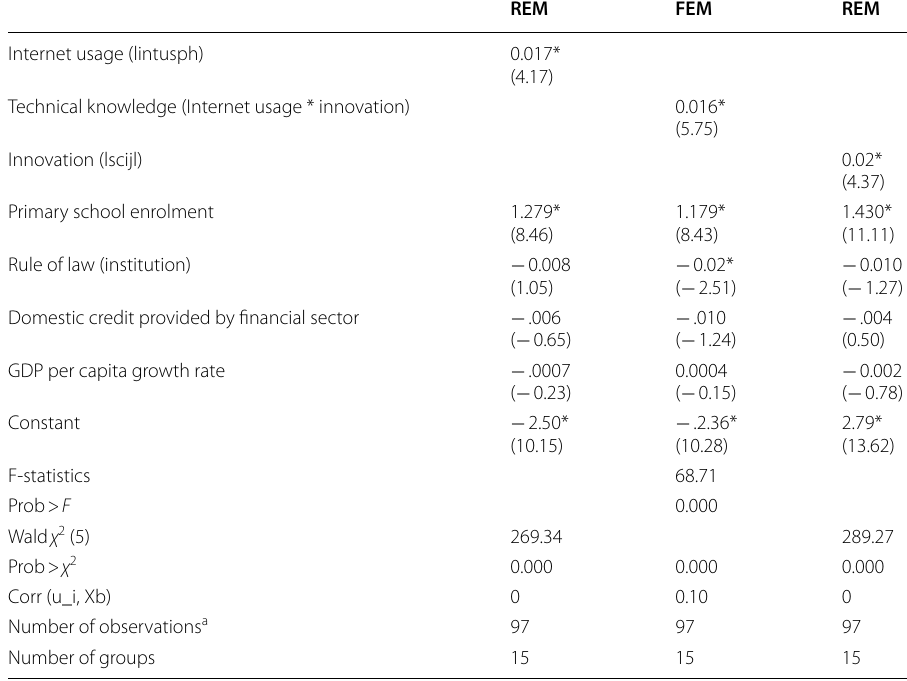
The values in the round parentheses ‘()’ are the t statistic values; *denotes that the coefficients are significant at 5% level. **Denotes that the coefficients are significant at 10% level a Notably, the number of observations used for the analysis seemed to be smaller compared to the number of observations in the descriptive statistics and this is attributed to the fact that the Gambia had missing data and, hence, was omitted from the data set to reduce panel attrition and there were few missing values in some other